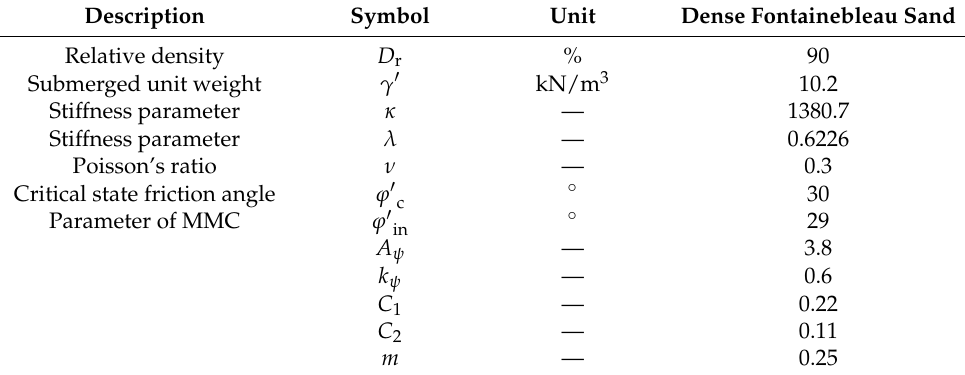
Table 3. Pile–soil interaction model parameters used for validation